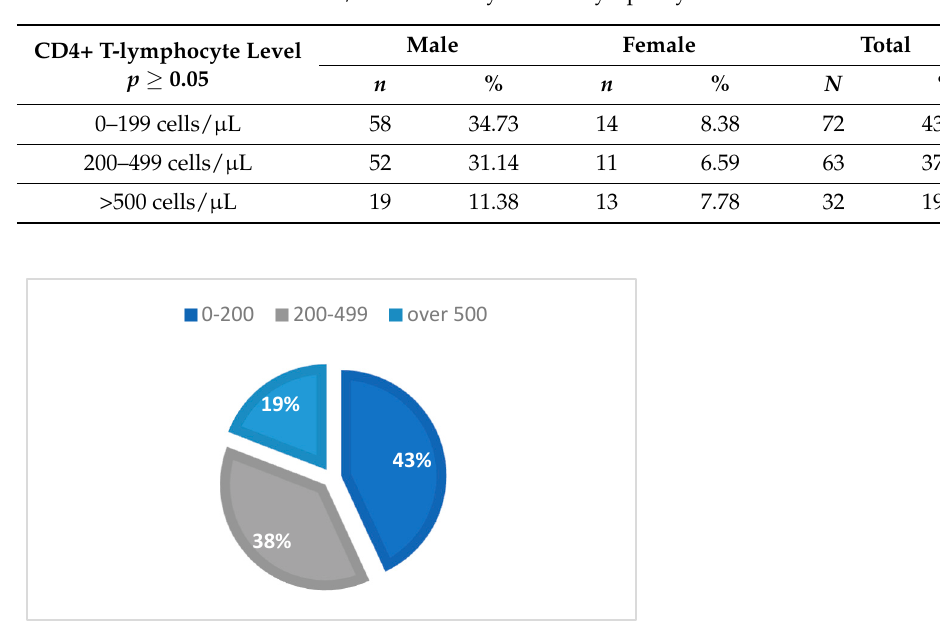
Table 4. Distribution of new HIV/AIDS cases by CD4+ T-lymphocyte level and sex.